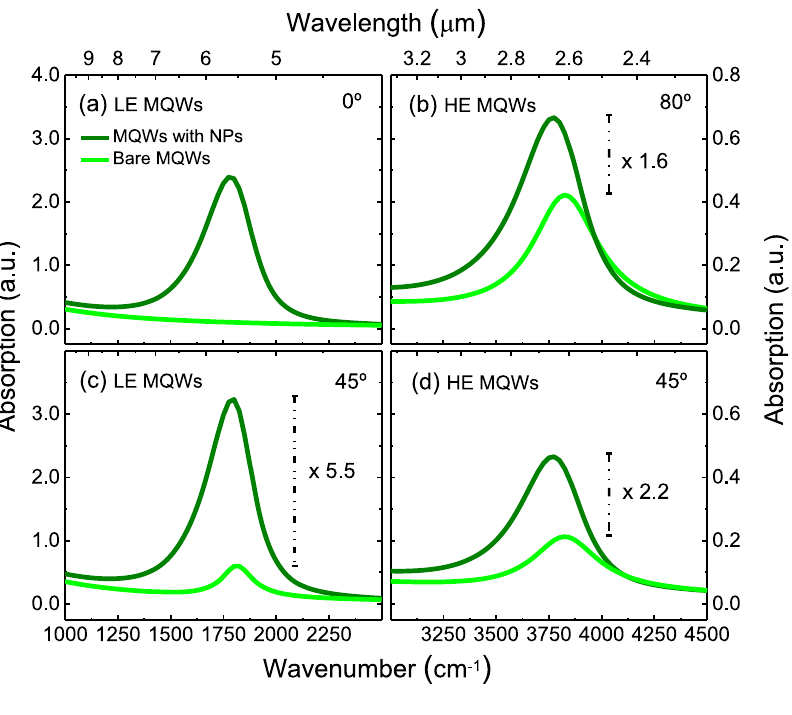
Figure 6: Light absorption enhancement in (a) MQWs coupled with the LE plasmonic mode at normal incidence; (b) MQWs coupled with the HE mode at 80 ° ; (c) MQWs coupled with the LE mode at 45 ° ; and (d) MQWs coupled with the HE mode at 45 ° . NP surface coverages of 32 and 75% are used whencouplingtheMQWstructurestotheLE andHEmodes,respectively.Theabsorption units can be compared among